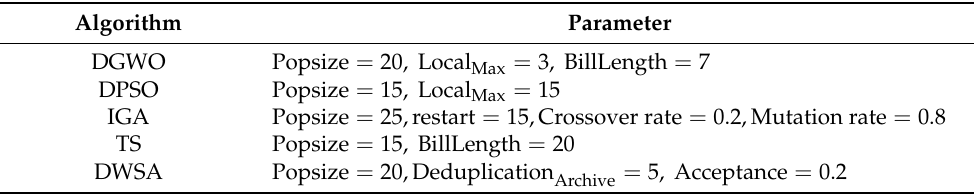
Table 2. Parameters values of other algorithms.